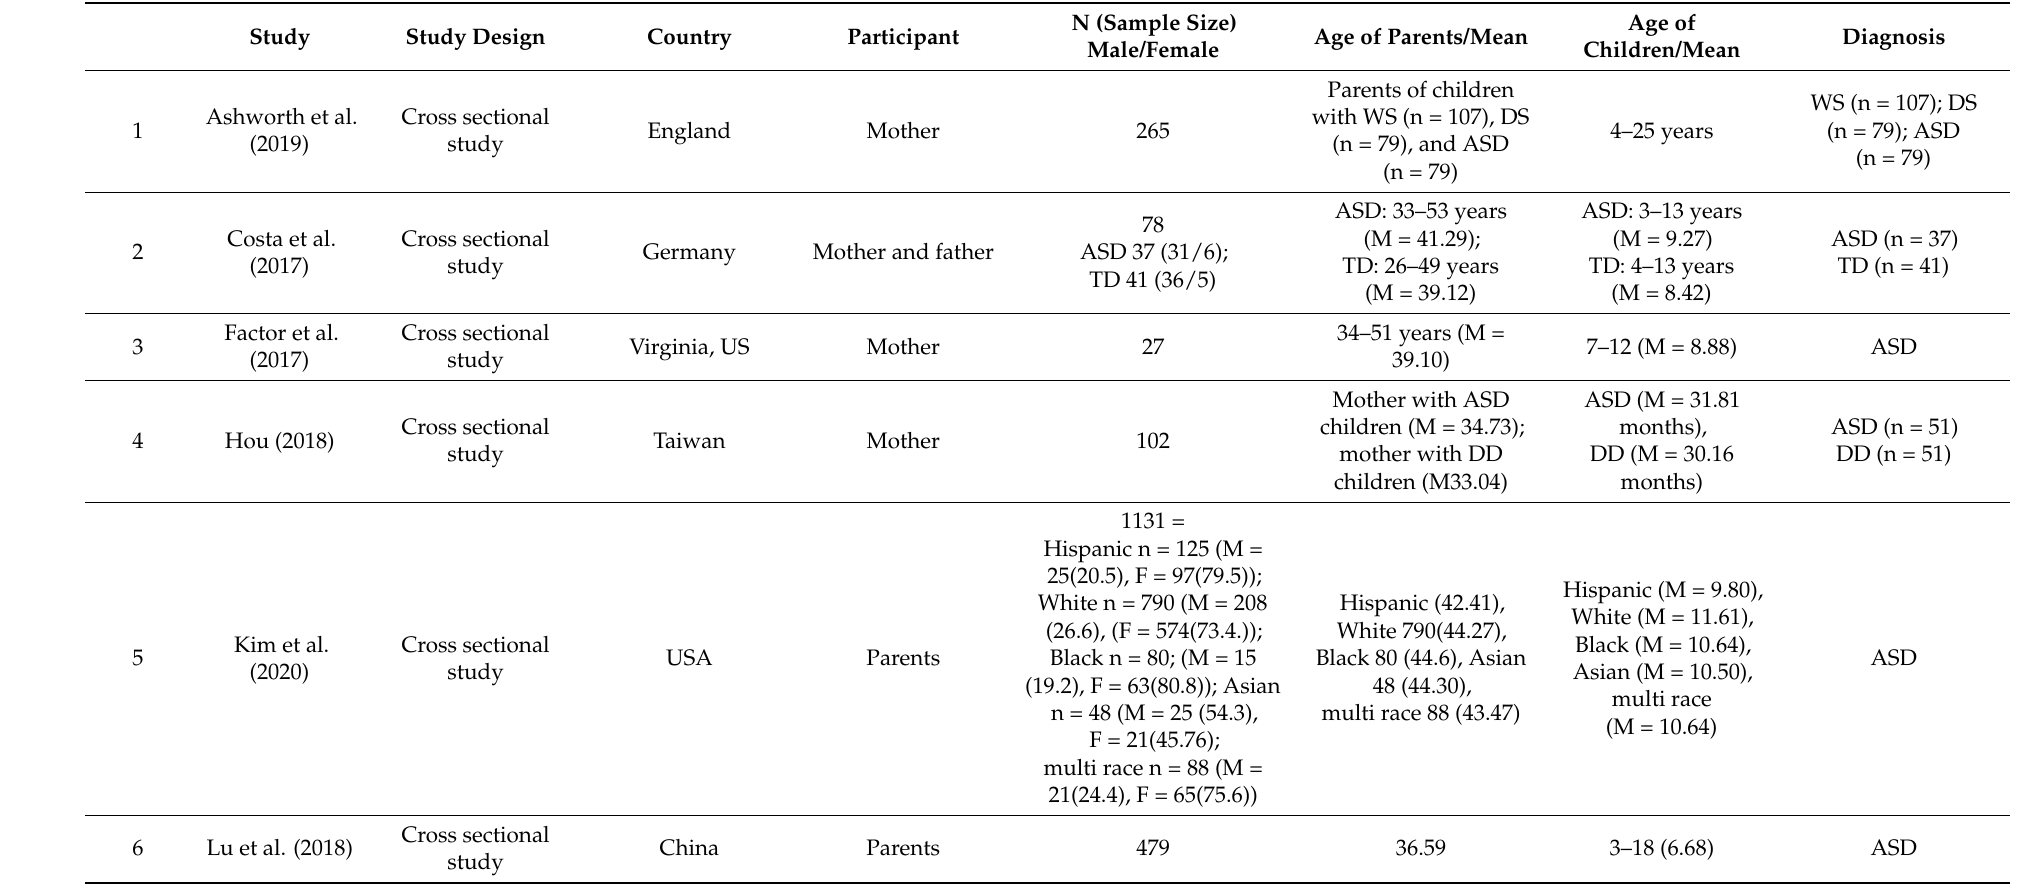
Table 1. Socio-demographic characteristics of the parents and